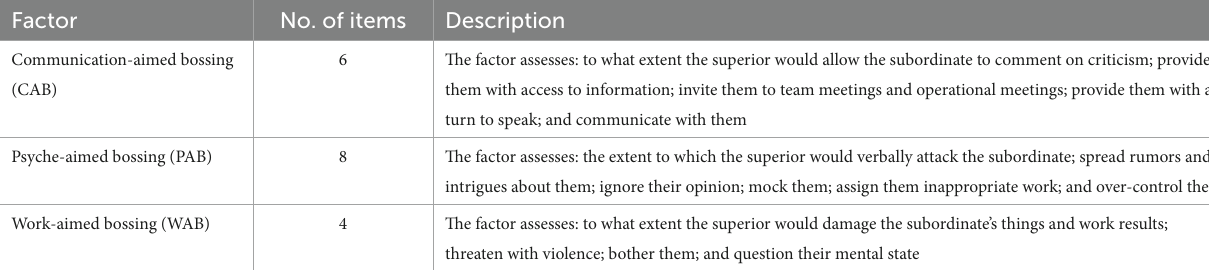
TABLE 1 Description of the factors of the BOSSm18 methodology.